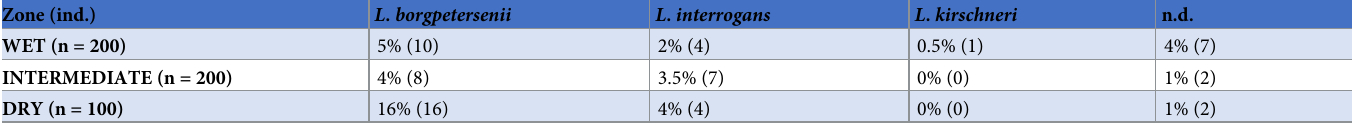
Table 2. Observed prevalence of pathogenic Leptospira spp. in each climate zone with number of infected individuals indicated in brackets. Zone